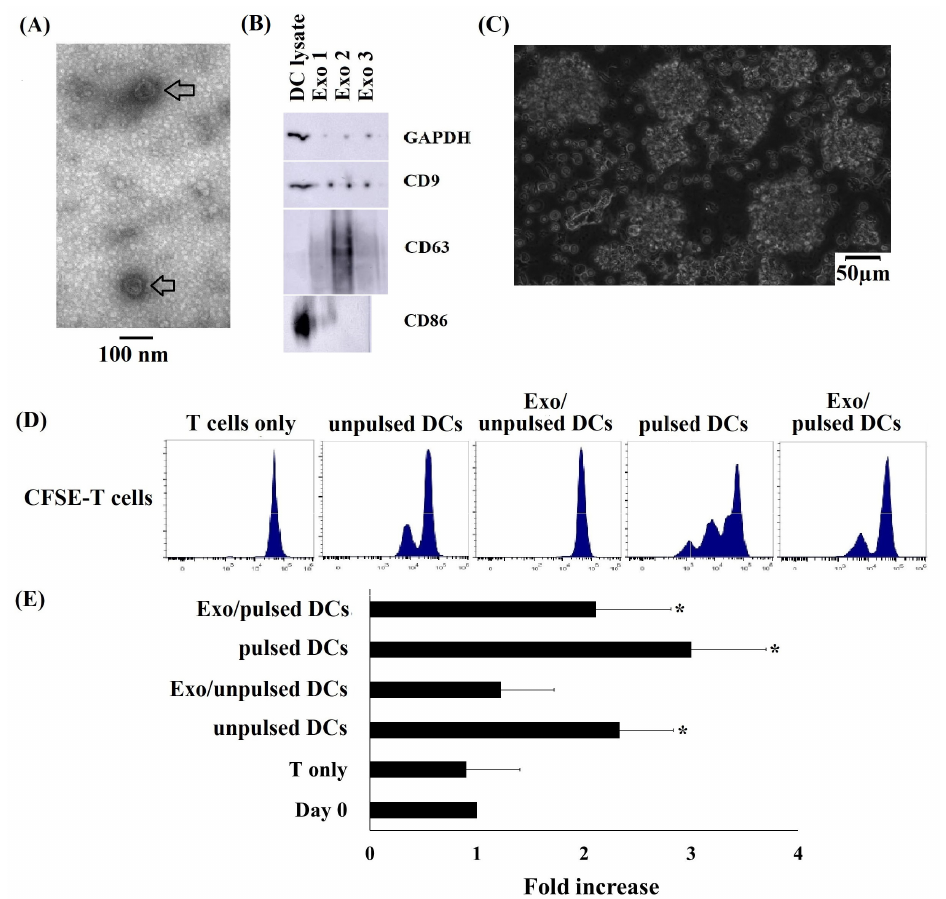
Figure 2. DCs and their exosomes induced allogeneic T cell proliferation. ( A ) A cup-shaped morphology was observed for pulsed DC-derived exosomes by TEM. ( B ) Pulsed DC-derived exosomes expressed CD9, CD63, and CD86. ( C ) AlloT cells grew as clumps when incubated with pulsed DCs. ( D ) Carboxyfluorescein succinimidyl ester (CSFE)-stained T cells proliferated during a seven-day incubation with pulsed DCs, unpulsed DCs and exosomes isolated from DCs. Untreated T cells or T cells incubated with exosomes isolated from Exo / unpulsed DCs did not divide. ( E ) The number of T cells increased highest in the treatment with pulsed DCs, followed by Exo / pulsed DCs, and unpulsed DCs. Exo / unpulsed DCs showed no significant e ff ect on alloT cell proliferation. Data was presented as mean ± SD in quadruplicate cultures (* p < 0.05). Exo1: pulsed DC-derived exosome sample 1; Exo2: pulsed DC-derived exosome sample 2; Exo3: pulsed DC-derived exosome sample 3. DCs: dendritic cells; pulsed DCs: A549 tumor cell lysate-pulsed DCs; unpulsed DCs: A549 tumor cell lysate-unpulsed DCs; Exo / unpulsed DCs: exosomes isolated from unpulsed DCs; Exo / pulsed DCs: exosomes isolated from pulsed